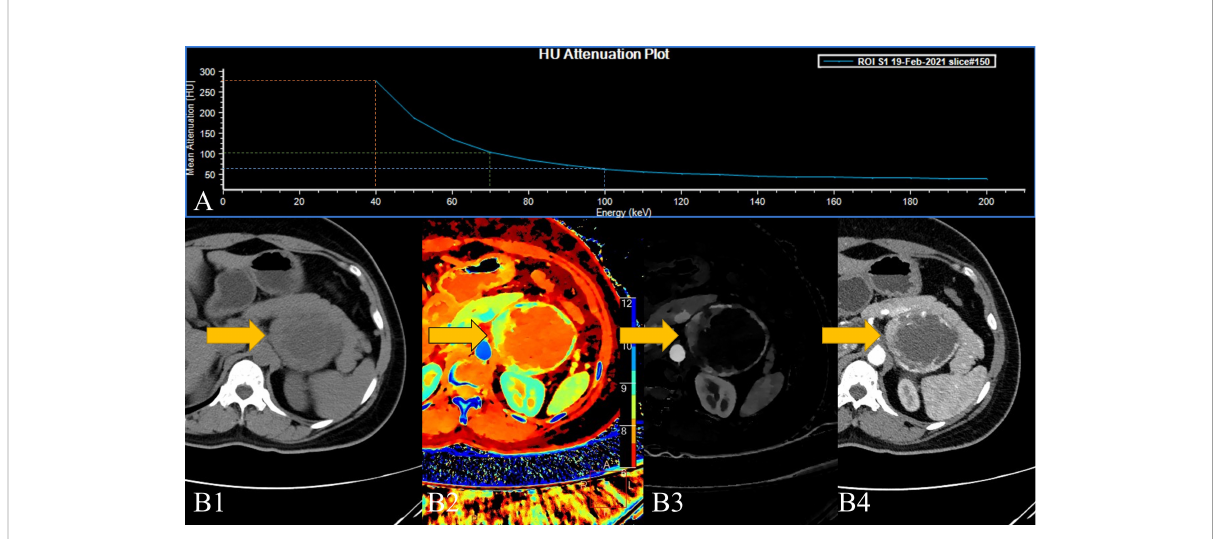
FIGURE 3 A 45-year-old female patient with a left adrenal lesion (yellow arrow); the pathological result was pheochromocytoma. (A) . The 40 – 200 keV HU attenuation plot. (B1) . Routine plain scan, (B2) . The effective atomic number can measure the effective atomic number of the lesion and help detect the lesion, and (B3) . AP-IC. (B4) . The 40 keV VMI based on arterial phase-enhanced